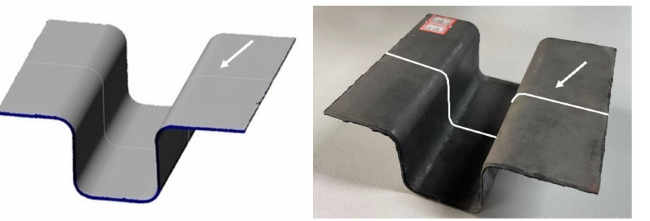
Figure 3. Schematic diagram of experimental the U-shaped part and thickness detection positions. The arrow position is the measurement